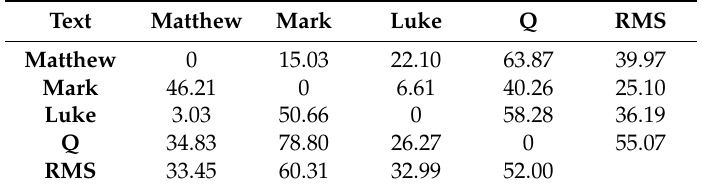
Table 10. Triple Tradition and Q. Kolmogorov–Smirnov test results for P F (below the diagonal of zeros) and C P (above the diagonal). The values reported are the confidence level (%) that the indicated couple of probability distributions are not